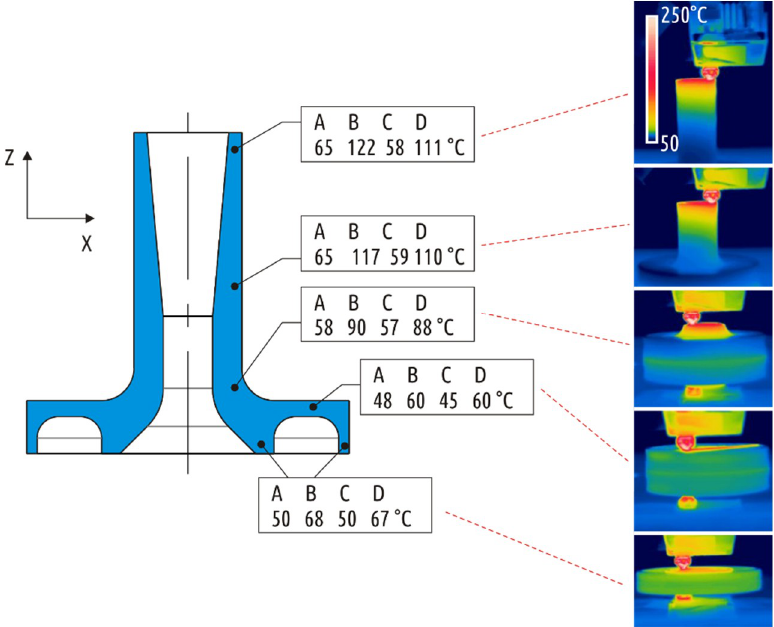
Figure 9. Sublayer temperature recorded at different stages of printing Shape 5 samples in modes A, B, C, and D (thermogram examples are given for mode B).